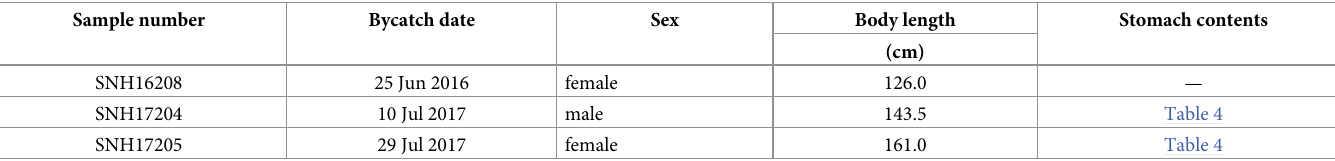
Table 2. Summary of harbour porpoise bycatch in the gillnet set off Rausu, Hokkaido, Japan, during the observation period. The stomach contents of specimen SNH16208 were not available. Sample